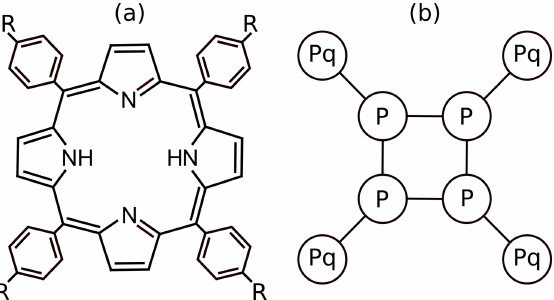
Figure 1. ( a ) Molecular structure of p -substituted porphyrin and ( b ) coarse-grained model of the porphyrin, where the square formed by P circles corresponds to the porphyrin aromatic ring and Pq is the charged